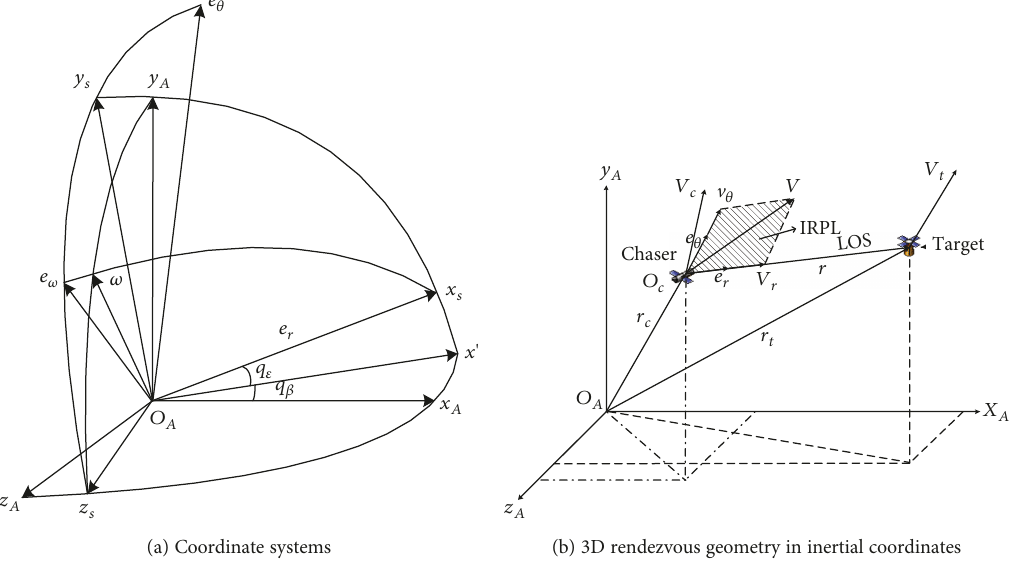
Figure 1: Reference frame for relative